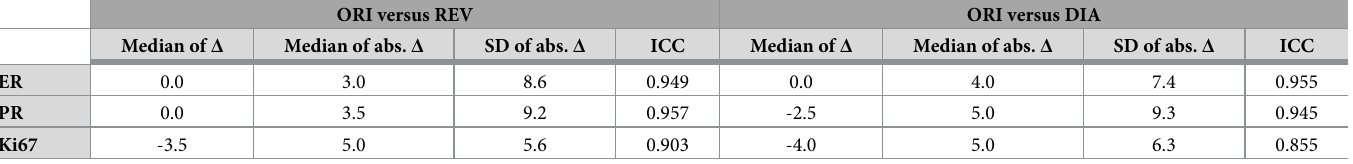
Table 3. Median proportion scores for